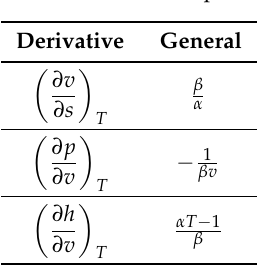
Table A3. Constant